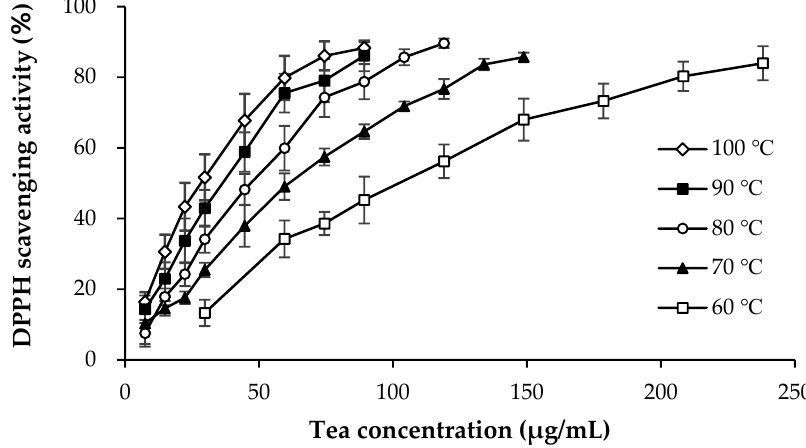
Figure 3. E ff ects of temperature on the DPPH scavenging activity of black Figure 3. Effects of temperature on the DPPH scavenging activity of black tea.